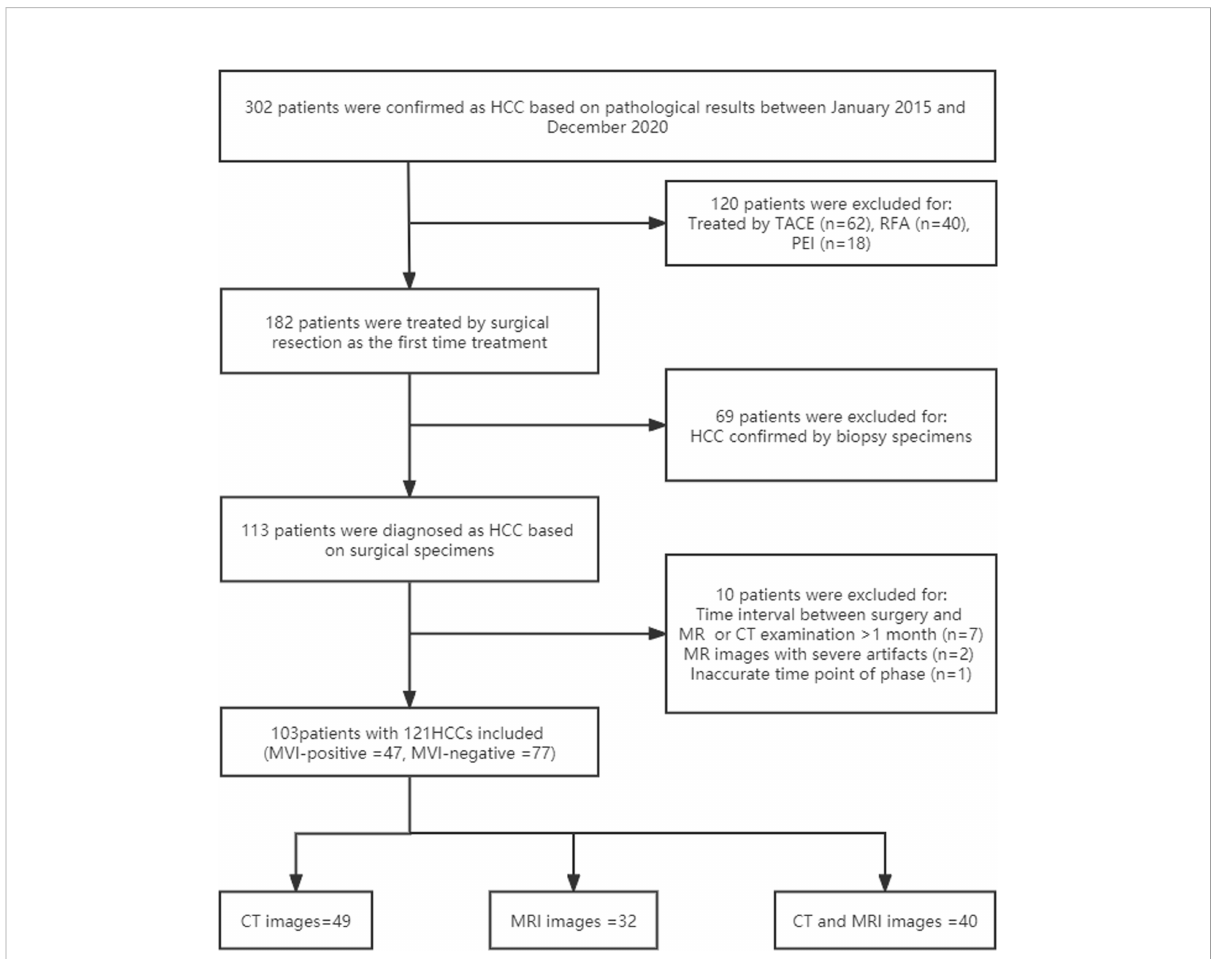
FIGURE 1 Flow chart for details. HCC, hepatocellular carcinoma; MVI, microvascular invasion; TACE, transcatheter arterial chemoembolization; RFA, radiofrequency ablation; PEI, percutaneous ethanol